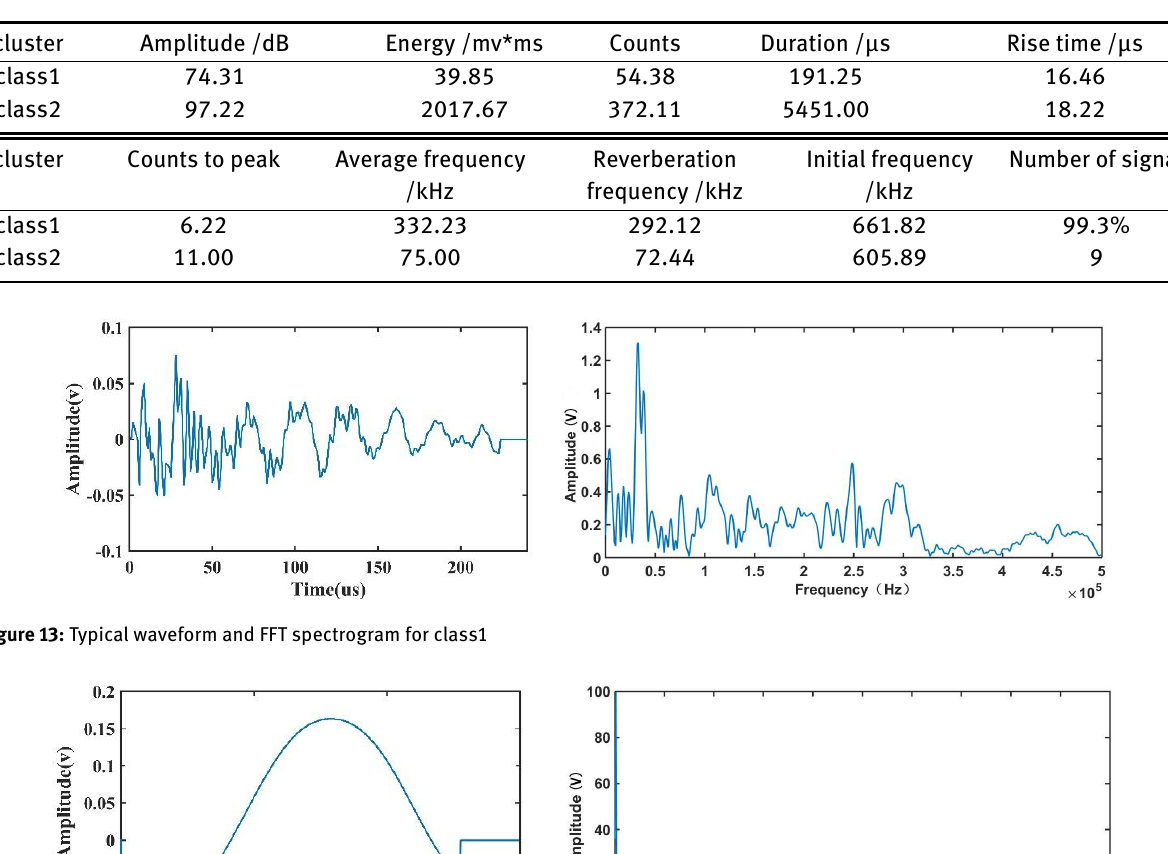
Table 5: Average value of AE parameters per cluster for fiber bundle tensile test